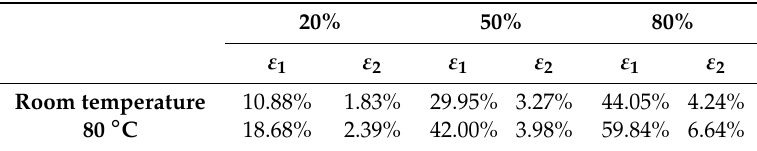
Table 1. ε 1 and ε 2 of all tested foam Table 1. ɛ 1 and ɛ 2 of all tested foam samples.